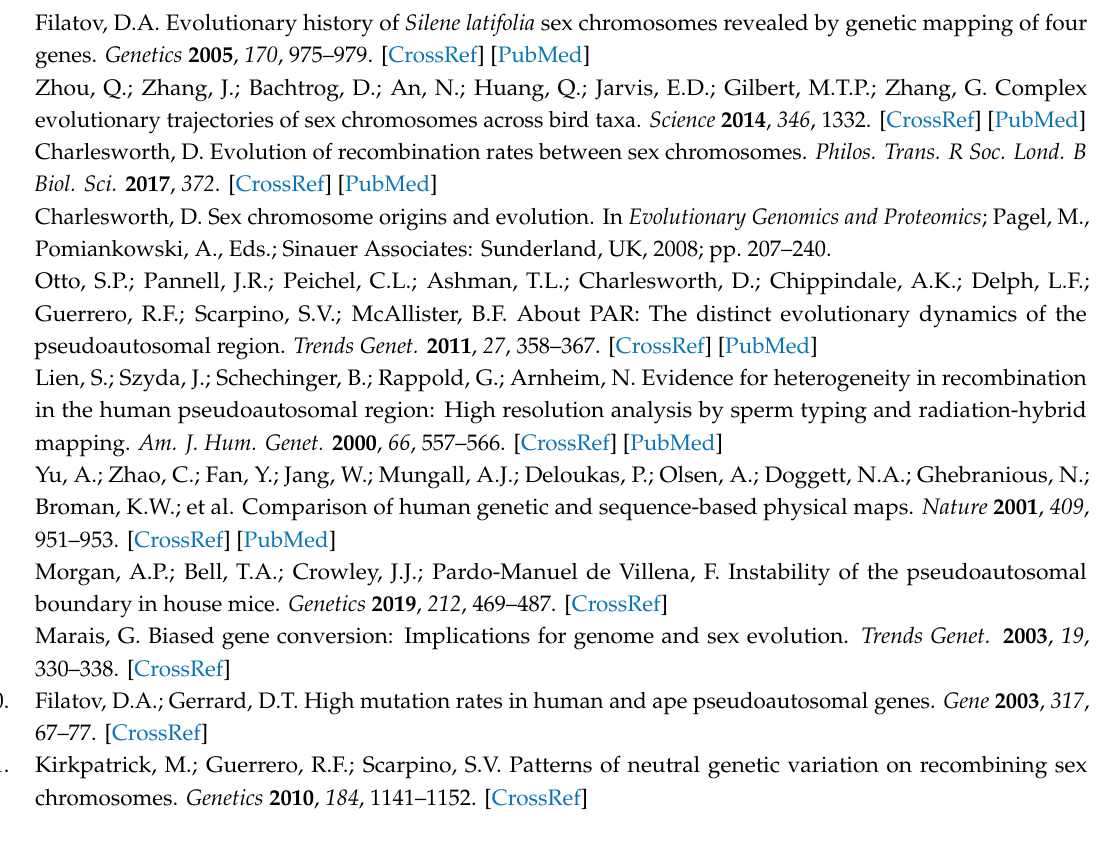
Table S1. Genotype of wild females at SNPs inherited from father to sons in the df108 family [47]; Table S2. Location of genes adjacent to PAR-boundary in the S. latifolia genomic scaffolds published by Papadopulos et al. 2015